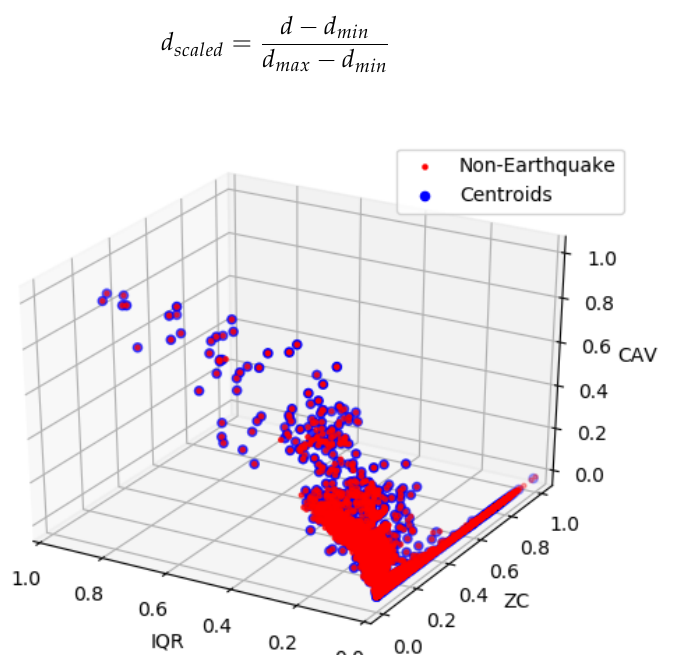
Figure 5. Centroids of the non-earthquake data (noise with some human